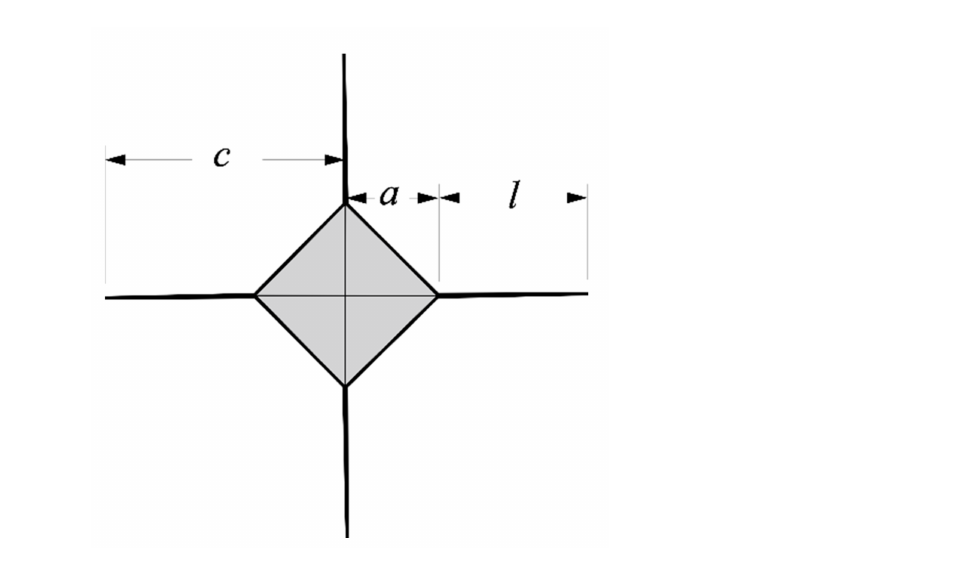
Figure 1. Illustration of surface crack geometry resulting from indentation with a Vickers pyramid.